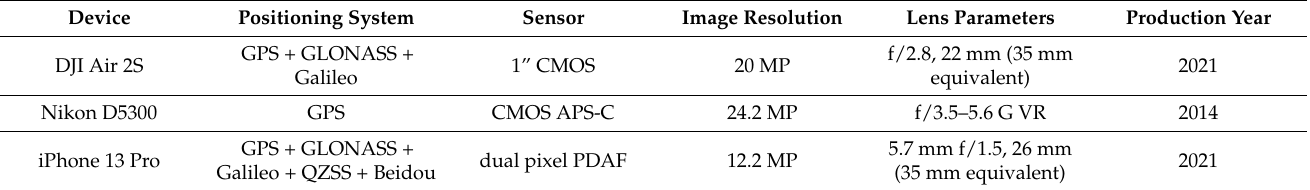
Table 1. In this table are summarized the parameters of the photographic devices used. Device Positioning